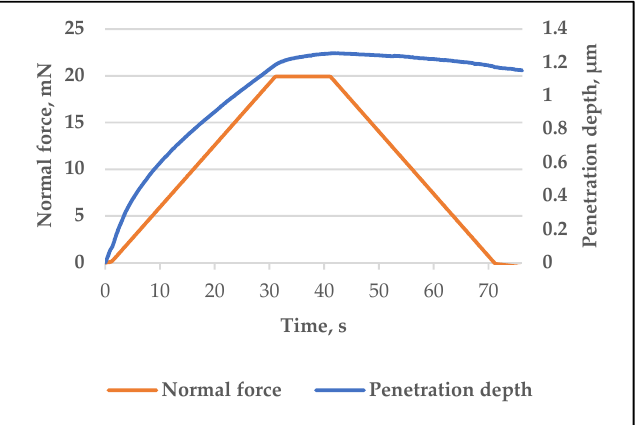
Figure 6. Graph registered during the hardness measurement of the varnish coating. Table 3. The results of the indenter depth penetration during the hardness measurement of the varnish coating. No. of Measurement and Depth of Penetration of the Indenter, µ